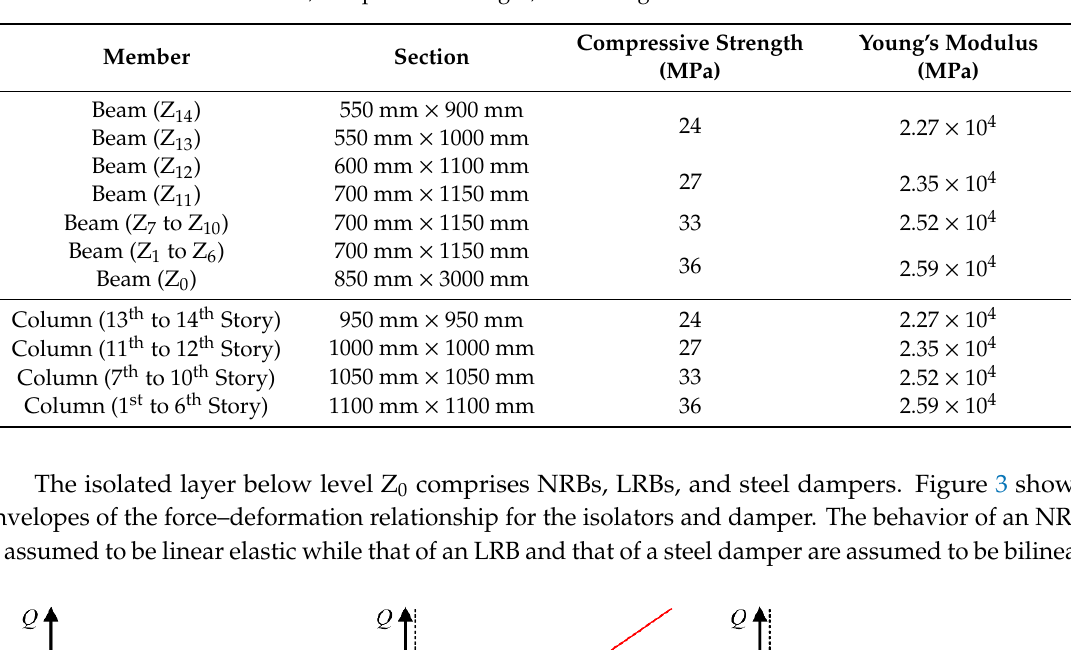
Table 2. Member sections, compressive strength, and Young’s modulus of concrete for Model-14.